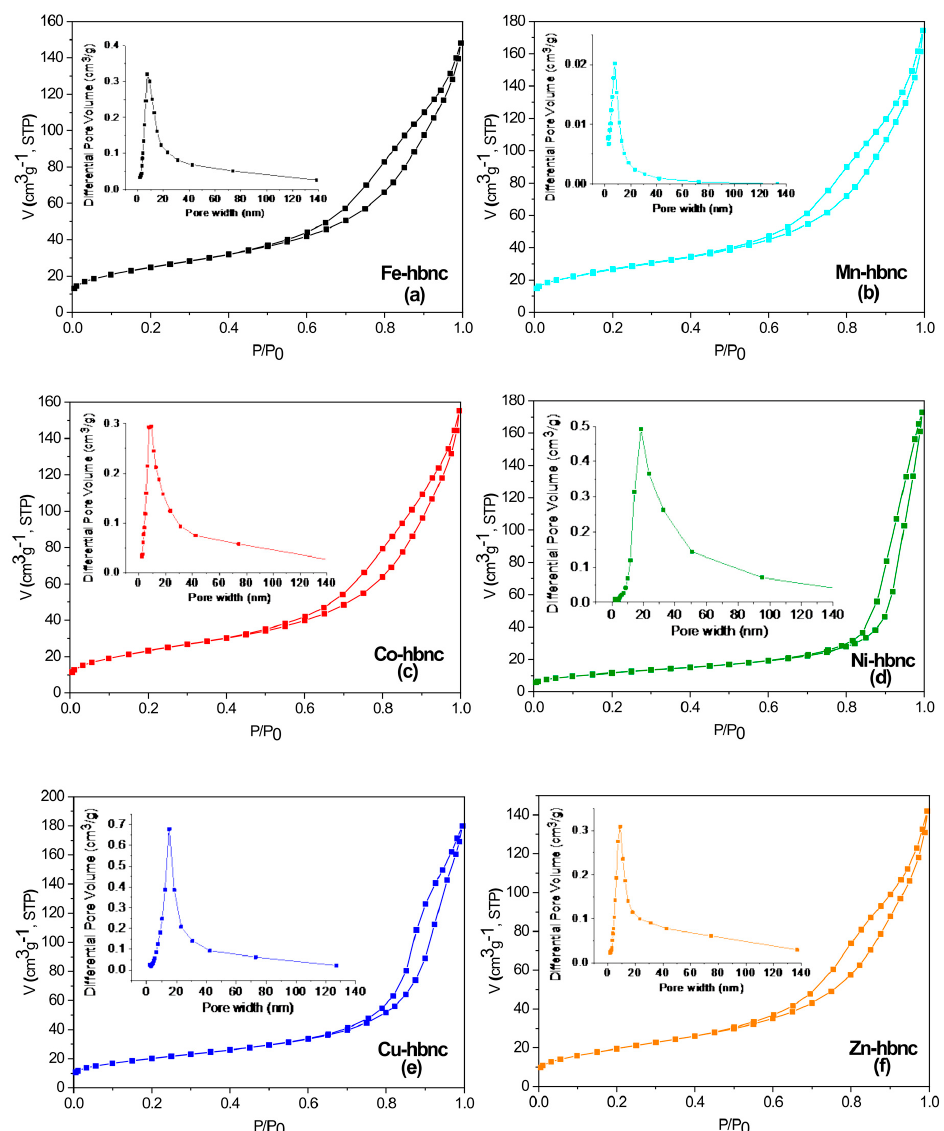
Figure 5. N 2 adsorption–desorption isotherms and pore size distribution (inset) of the samples: Fe − hbnc ( a ), Mn − hbnc ( b ), Co − hbnc (c) , Ni − hbnc ( d ), Cu − hbnc ( e ), and Zn − hbnc ( f ).